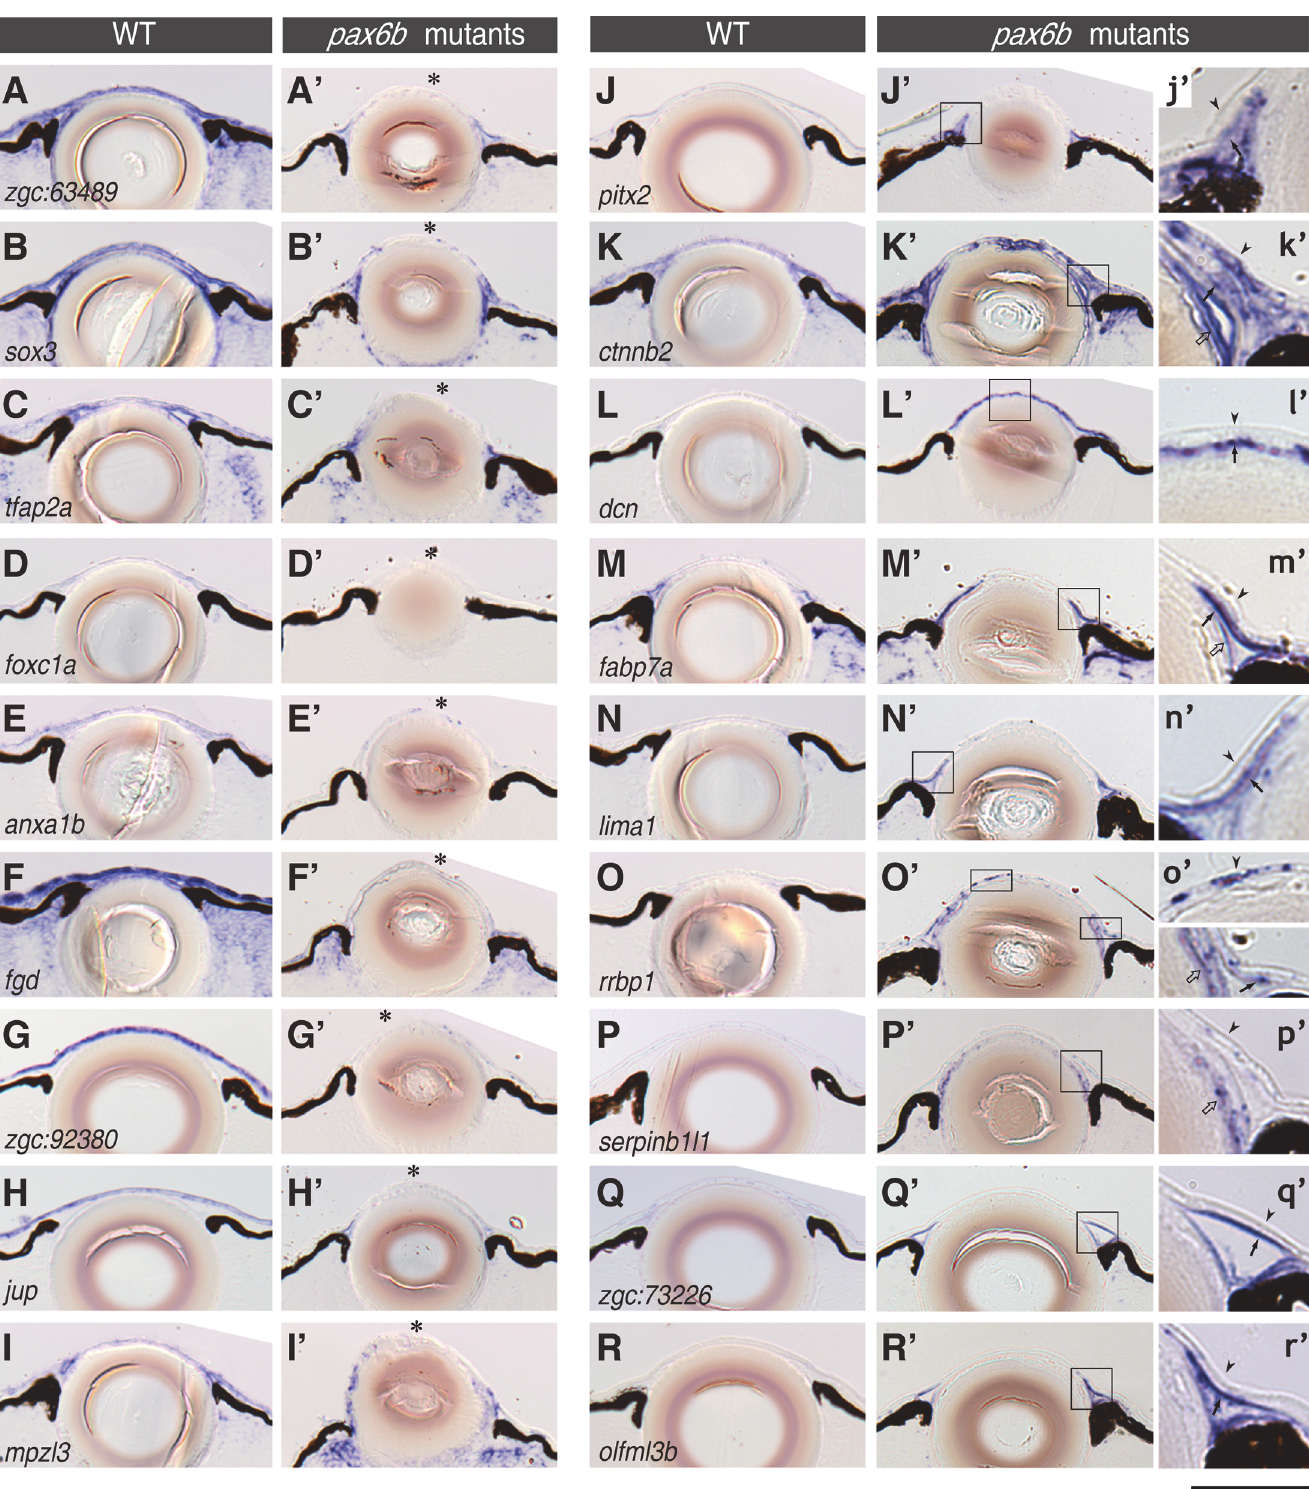
Fig 7. Gene expression in the cornea is severely affected in pax6b mutants. The distribution of the mRNA of cornea genes was compared at 7 dpf between wildtype (A-R) and pax6b mutant embryos (A ’ -R ’ ). Each panel represents a transverse section through the eye and the lens. The gene transcripts analysed by in situ hybridization are zgc : 63489 (A-A ’ ), sox3 (B-B ’ ), tfap2a (C-C ’ ), foxc1a (D-D ’ ), anxa1b (E-E ’ ), fgd (F-F ’ ), zgc : 92380 (G-G ’ ), jup (H-H ’ ), mpzl3 (I-I ’ ), pitx2 (J-J ’ ), ctnnb2 (K-K ’ ), dcn (L-L ’ ), fabp7a (M-M ’ ), lima1 (N-N ’ ), rrbp1 (O-O ’ ), serpinb1l1 (P-P ’ ), zgc : 73226 (Q-Q ’ ) and olfml3b (R-R ’ ). (A-I ’ )